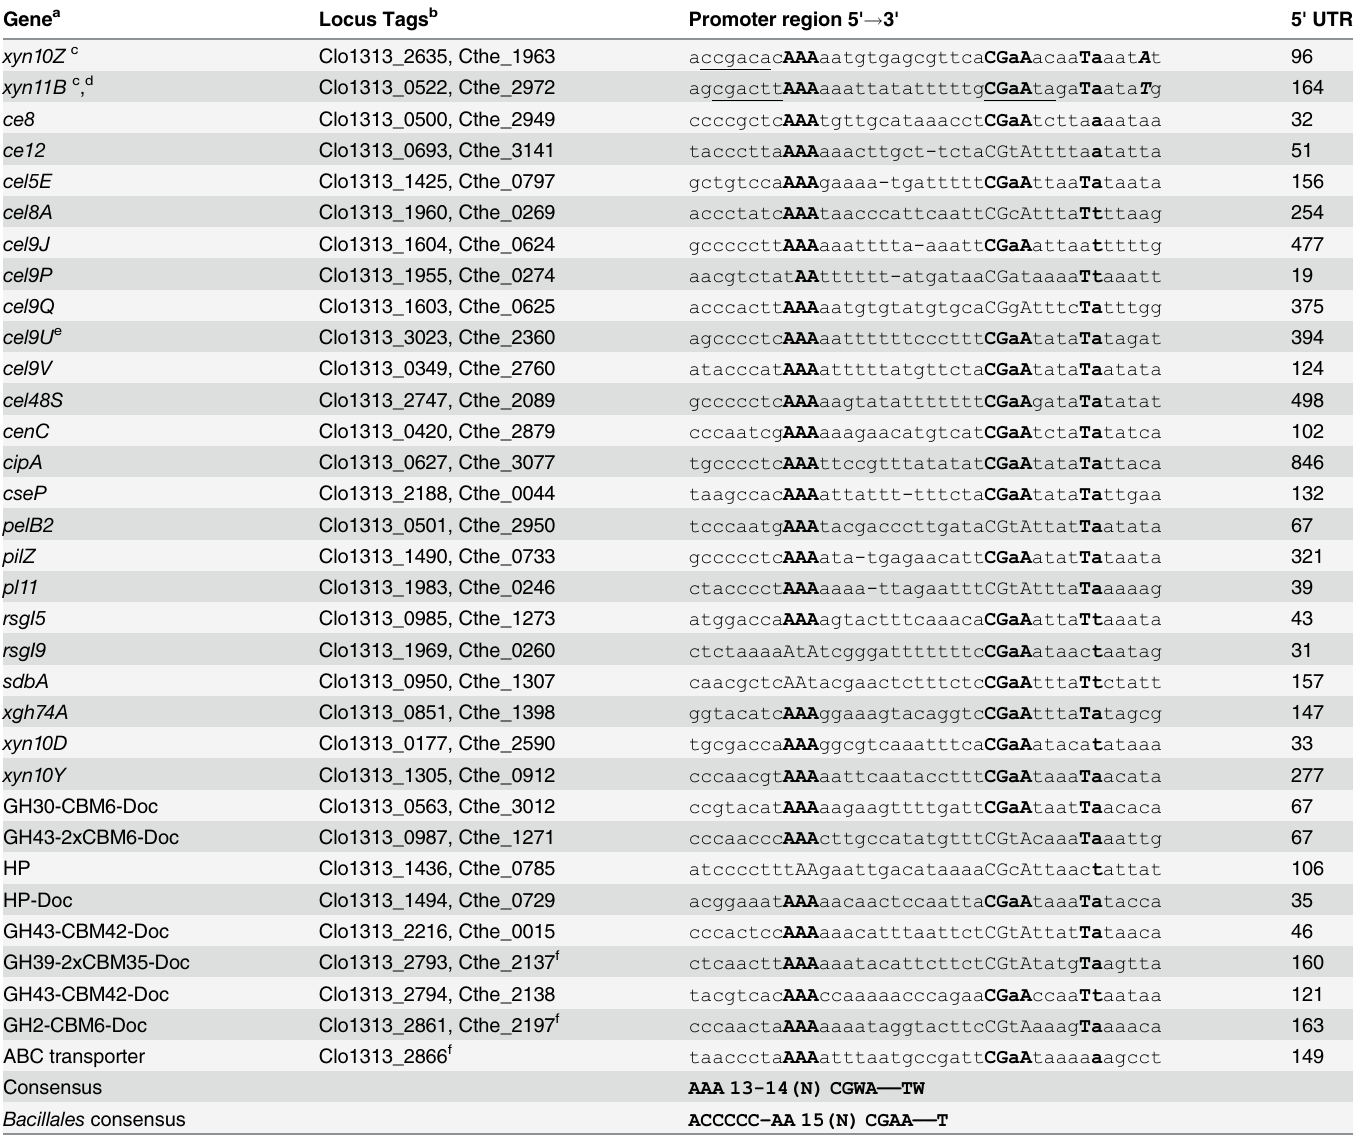
Table 2. Alignment of predicted C . thermocellum σ I -dependent